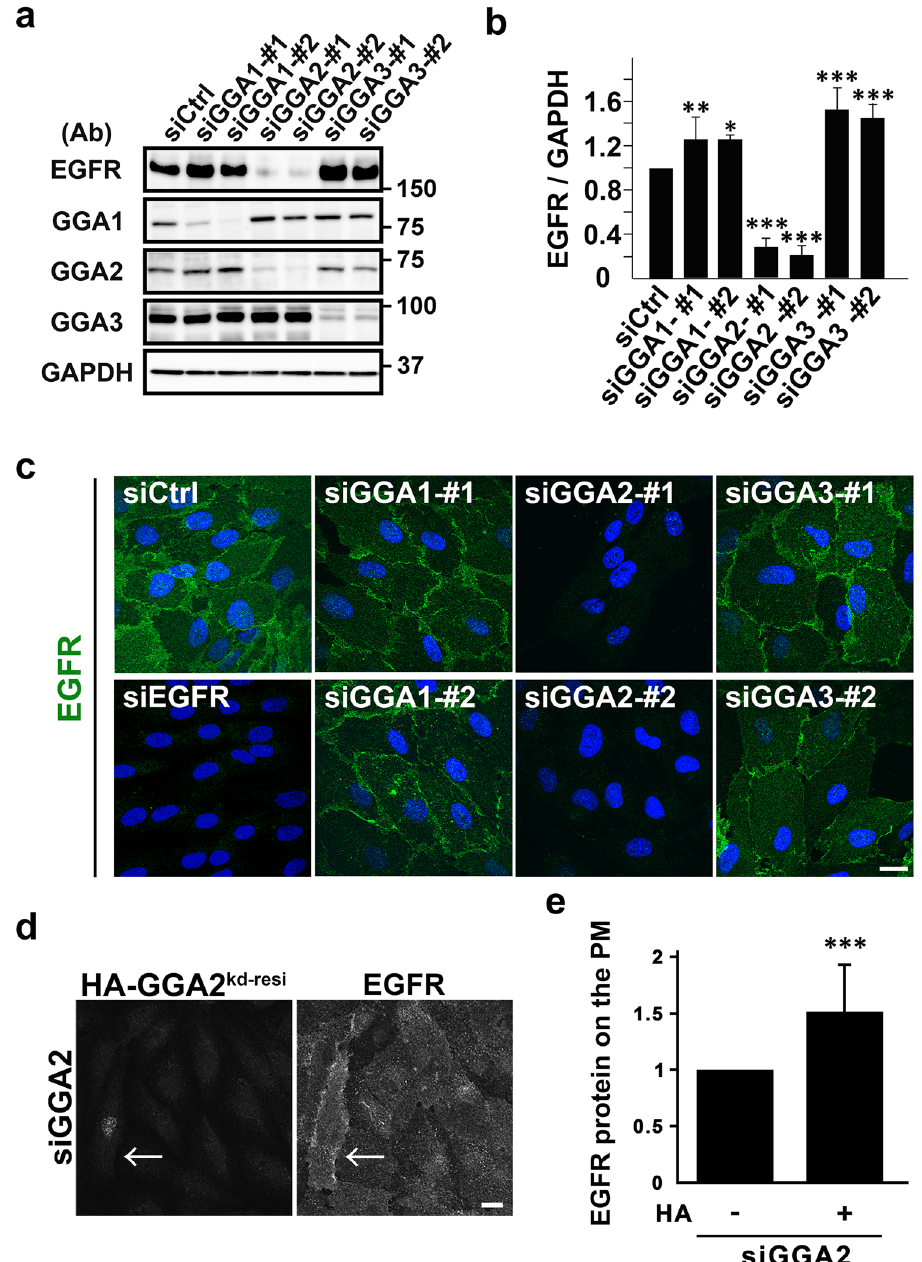
Figure 1. GGA2-depletion causes a drastic decrease in the EGFR protein expression. ( a ) Total lysates from ARPE-19 cells transfected with control (siCtrl), GGA1, GGA2, or GGA3 siRNAs were immunoblotted using indicated antibodies (Ab). Two sequences of siRNA (#1 and #2) were used for each GGA. Uncropped blots are presented in Supplementary Fig. 6. ( b ) Band intensities for EGFR were quantified in three or four experiments and mean values ± standard deviations (SD) were plotted. Differences between each GGA siRNA and siCtrl were analyzed by one-way ANOVA ( P < 0.001) and Tukey’s honestly significant difference test ( * P < 0.05, ** P < 0.01, and *** P < 0.001). ( c ) Cells were treated with indicated siRNAs and were then fixed for immunofluorescence microscopy using anti-EGFR antibody. Nuclei were stained with Hoechst 33342 (blue); Bar, 20 μ m. ( d ) GGA2-depleted cells re-expressing HA fused with siRNA-resistant full length GGA2 (HA-GGA2 kd-resi ) were double immunolabeled with anti-HA and -EGFR antibodies. Signal intensity for EGFR was enhanced to detect differences. The arrow indicates a cell expressing HA-GGA2 kd-resi . Bar, 20 μ m. ( e ) EGFR signal on the plasma membrane in HA-positive (n = 95) and -negative cells (n = 177) was quantified. Statistical analysis was performed using Student’s t -test ( *** P < 0.001). See Materials and Methods for